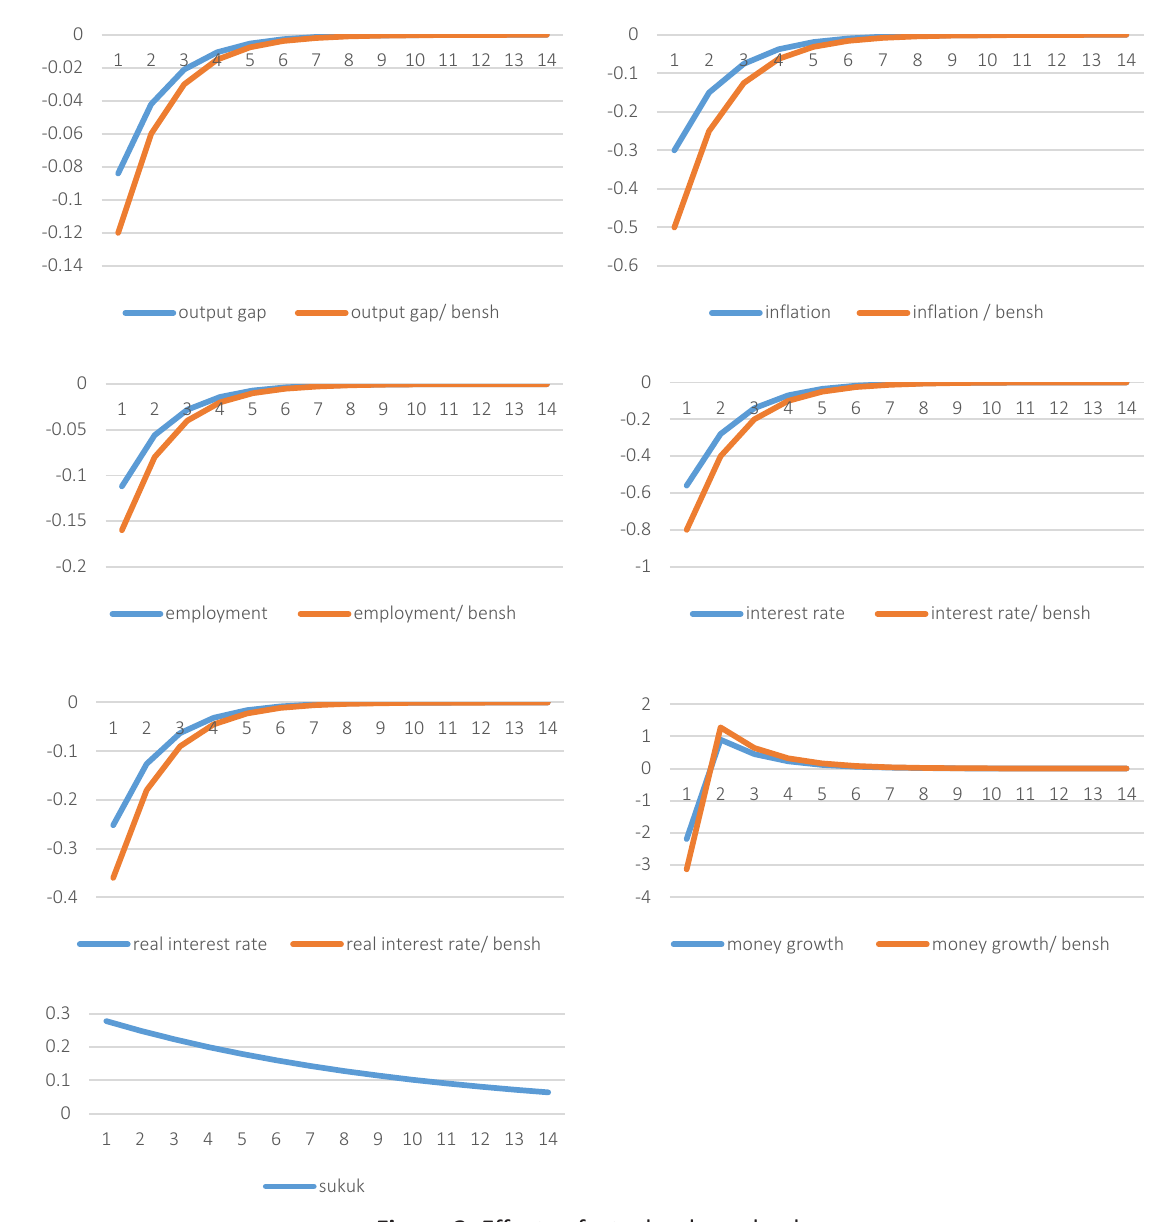
Figure 2. Effects of a technology